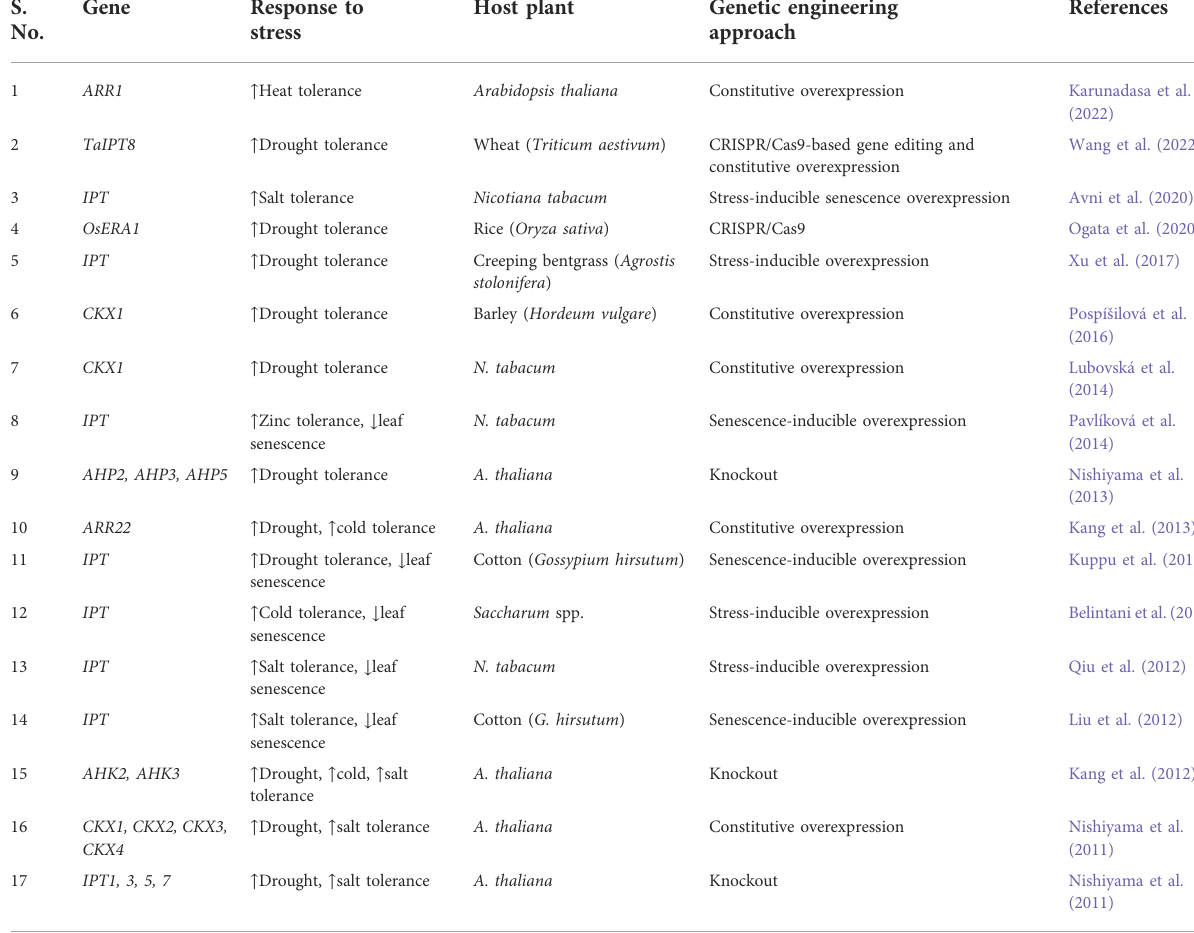
TABLE 2 A list of CK signaling genes involved in the development of abiotic stress-tolerant plants. S.